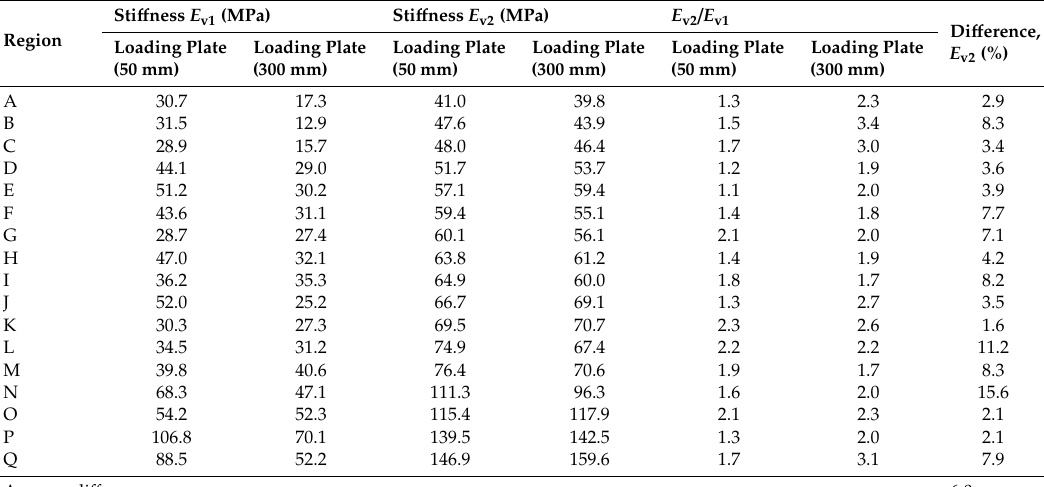
Table 3. Repetitive plate loading field-test results (Jung et al.